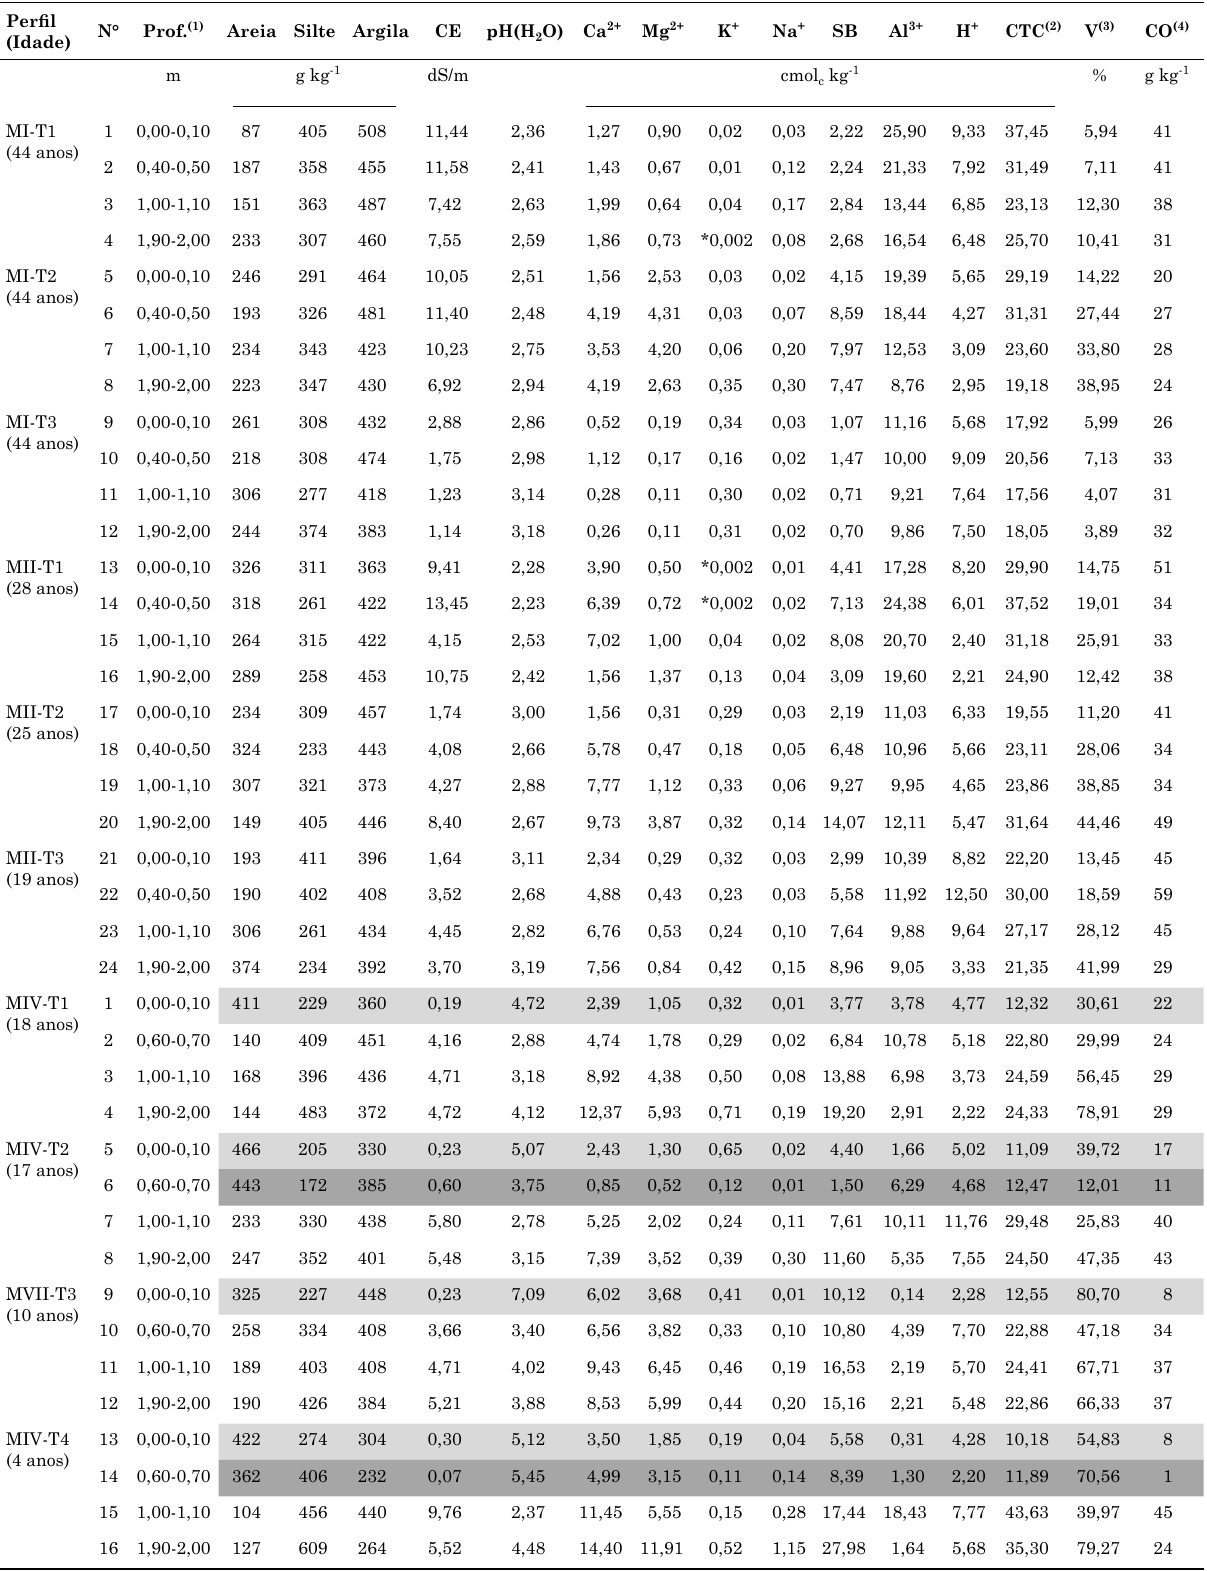
Quadro 2. Propriedades físicas e químicas dos perfis de solos construídos com diferentes idades Perfil